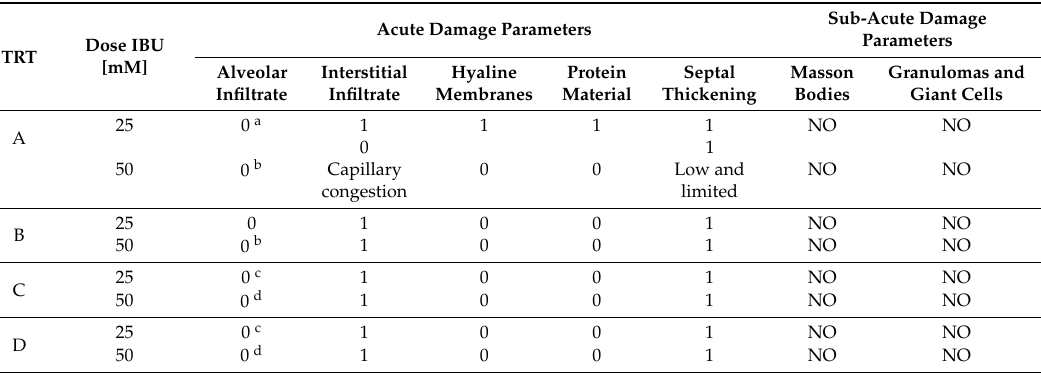
Table 1. Histological analysis of rats´ lungs treated with